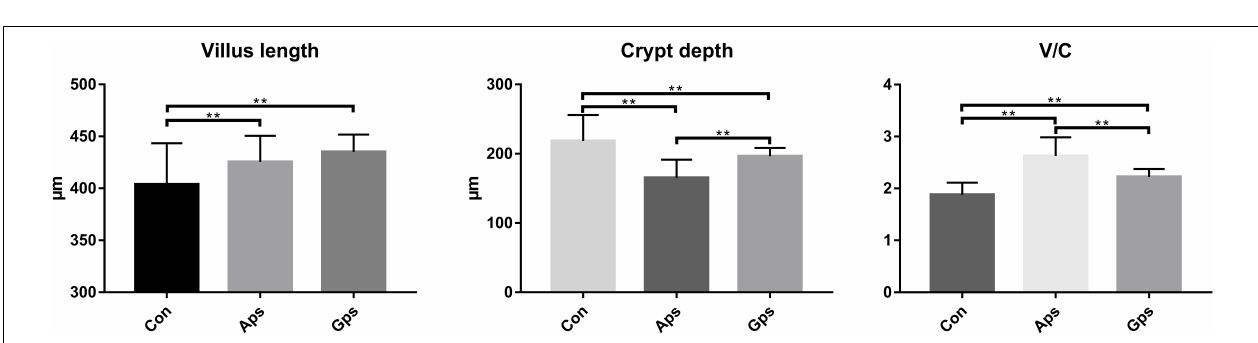
FIGURE 2 | Effect of the Aps and Gps on the serum immunoglobulins in weaned piglets. Con represents the control piglets on d 14 and 28, respectively; Aps represents the piglets supplemented with the astragalus polysaccharide on d 14 and 28, respectively; Gps represents the piglets supplemented with ginseng polysaccharide on d 14 and 28, respectively. ∗ Means significant different ( P < 0.05), ∗∗ Means significant difference ( P < 0.01). Values means n = 6 for the analysis of serum immunoglobulins.